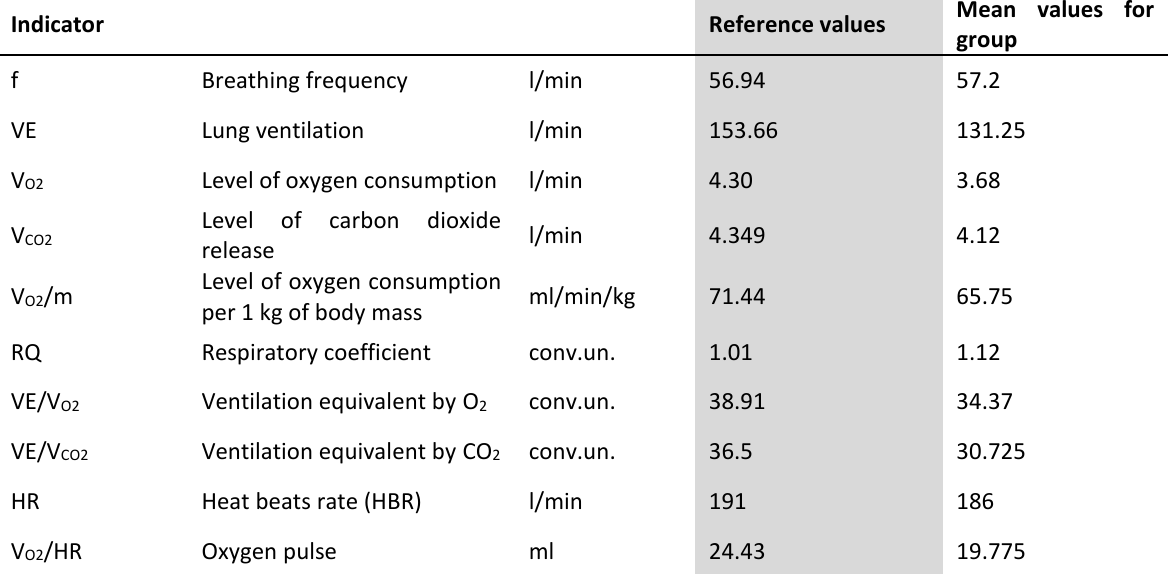
Table 1. Reference and mean-group values of respiratory and blood circulation functional indicators of sportsmen, -